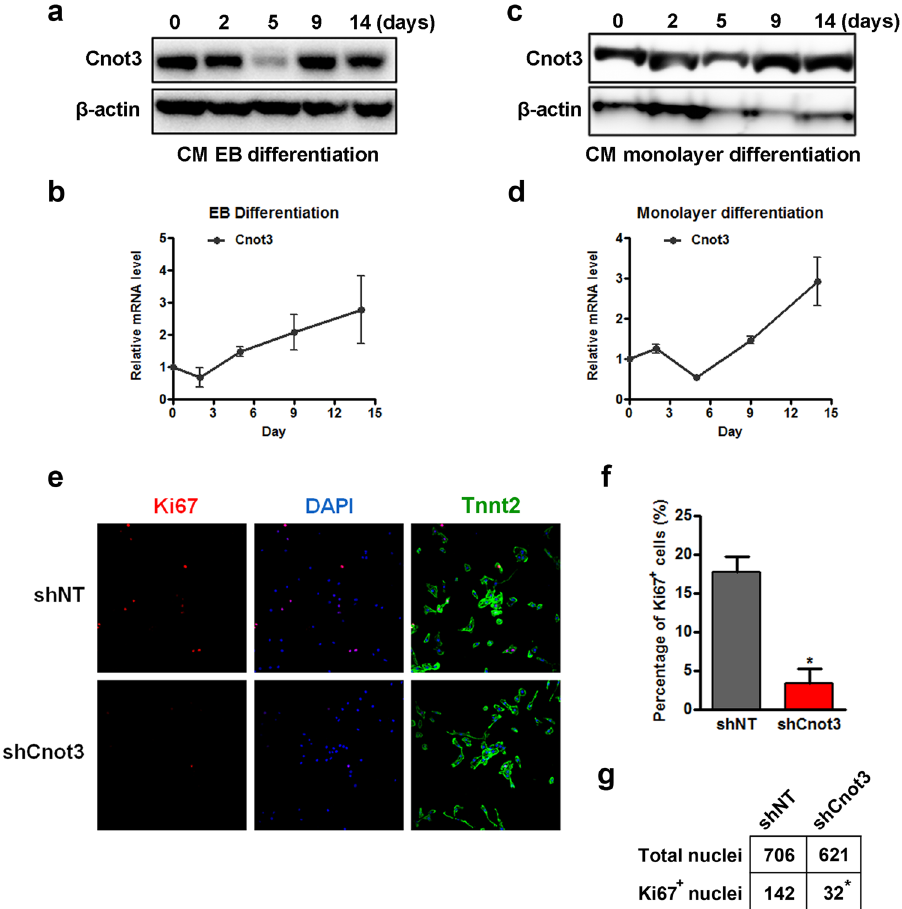
Figure 2. Cnot3 plays an important role in cardiomyocyte proliferation. ( a , b ) hESCs were induced to differentiate into cardiomyocytes by EB suspension culture. The expression of Cnot3 was determined by western blotting ( a ) and qPCR ( b ) at the indicated time points, respectively. β -actin was used as loading control in western blot and endogenous control in RT-PCR. The blots were cropped since different antibodies were incubated at the same time. ( c , d ) hESCs were induced to differentiate into cardiomyocytes by monolayer culture. The expression of Cnot3 was determined by both western blotting ( c ) and qPCR ( d ) at the indicated time points. β -actin was used as loading control in western blot and endogenous control in RT-PCR, respectively. ( e ) Representative images of immunofluorescence staining against Ki67 and Troponin T2 (TnnT2) to show the impacts of Cnot3 depletion on the proliferation of hESC-derived cardiomyocytes. ( f ) Ki67 positive cells were counted, and percentage of Ki67-positive cells was calculated and plotted as mean ± SEM from ten images from three independent experiments, * p < 0.05. ( g ) Ki67 positive nuclei were counted from ten images from three independent experiments, and significance was calculated by chi-square test, * p <